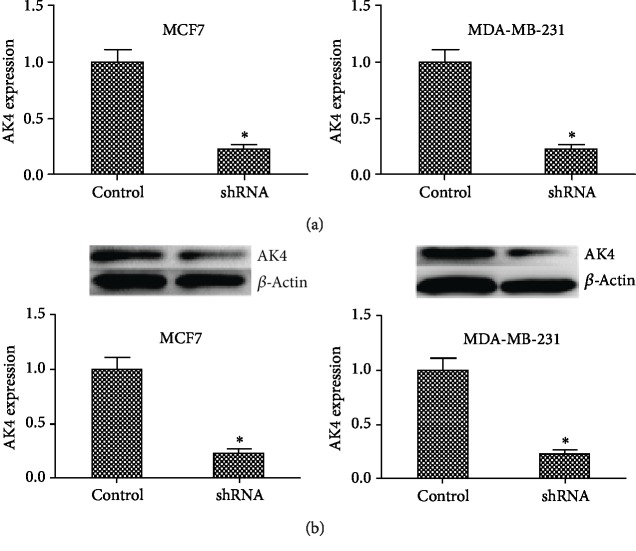
AK4 expression levels were markedly decreased in both MCF7 and MDA-MB-231 cells caused by its shRNA transfection. (a) Quantitative PCR assays showed the dramatically reduced expression levels of AK4 after the transfection of its shRNA in MCF7 and MDA-MB-231 cells, respectively. (b) Immunoblot assays showed the efficient decrease of AK4 expression caused by the transfection of its shRNA plasmids in both MCF7 and MDA-MB-231 cells. Results are presented as mean ± SD, ∗P < 0.05.